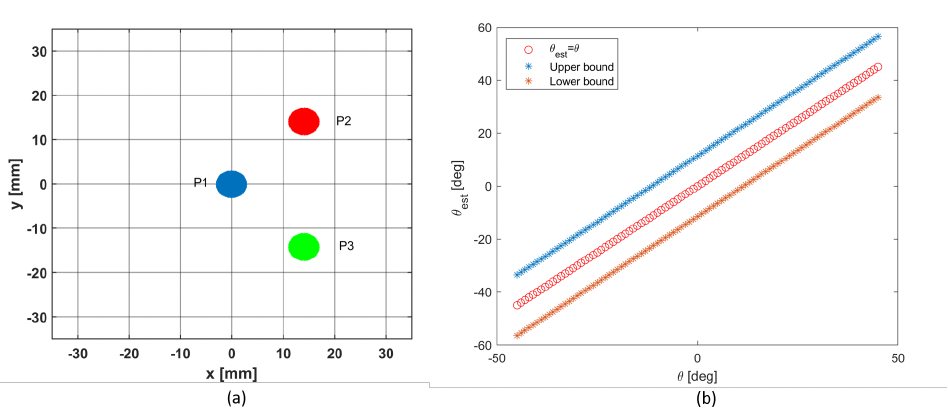
Figure 3. ( a ) The conventional cluster of 3 circular piezo-sensors spaced apart by a distance d CC = 20 [ mm ] . ( b ) Upper and lower error bounds of the conventional